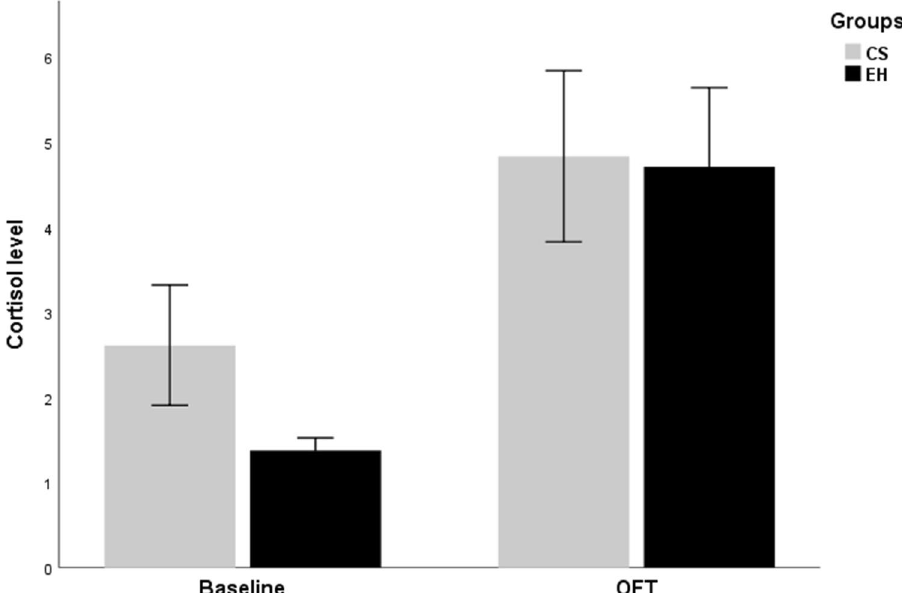
Figure 1. Cortisol levels in ng/mL for chronically stressed dogs (CS) and emotionally healthy dogs (EH) for the baseline and Open Field Test (OFT) conditions. Mean values are depicted, and error bars indicate standard